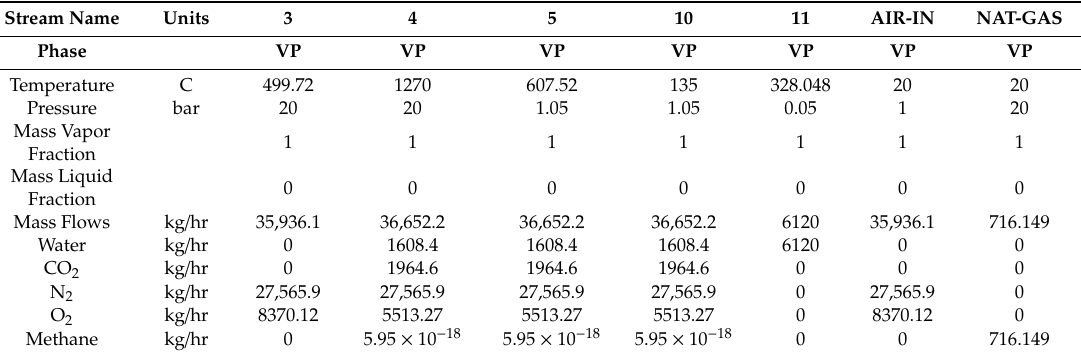
Figure 6. Computer simulation of the combined-cycle gas turbine. Table 5. Results of computer simulation of the combined-cycle gas